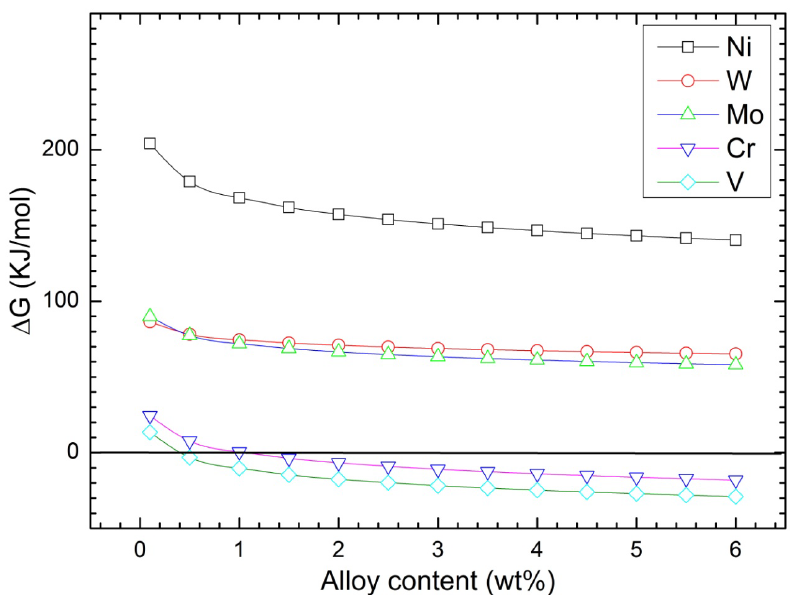
8 of 13 Figure 3. Effect of C content on activity coefficients of alloying elements at 1873 K. Figure 4 shows